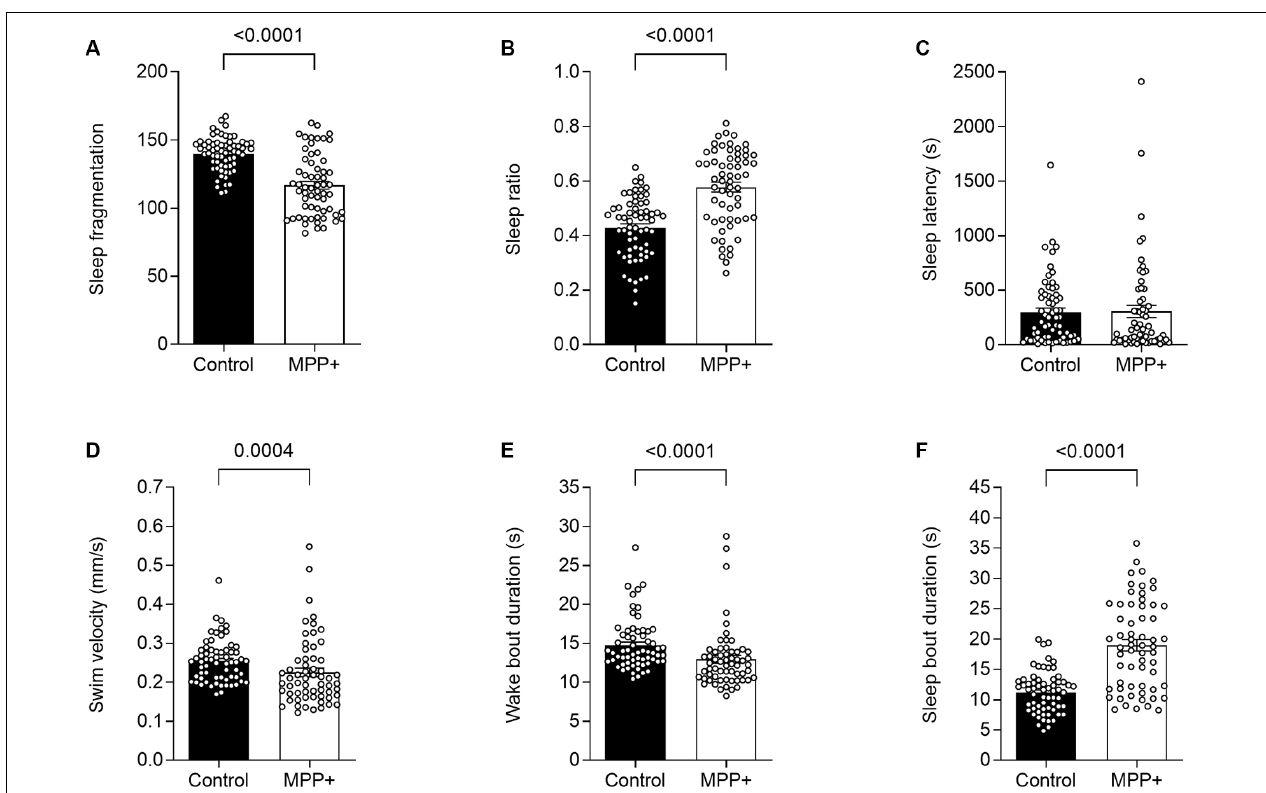
FIGURE 3 | MPP+ effects on sleeping pattern of zebrafish larvae. Sleeping pattern was evaluated in absence (Control) or presence of 500 µ M MPP+ for (A) sleep fragmentation; (B) sleep ratio; (C) sleep latency (s); (D) swim velocity (mm/s); (E) wake bout duration (s) and (F) sleep bout duration (s). Data are presented as means ± SEM from two independent experiments pooled, control group n = 64, MPP+ group n = 61. Normality was tested using D’Agostino and Pearson omnibus normality test followed by a two-tailed unpaired t -test or nonparametric two-tailed Mann–Whitney U